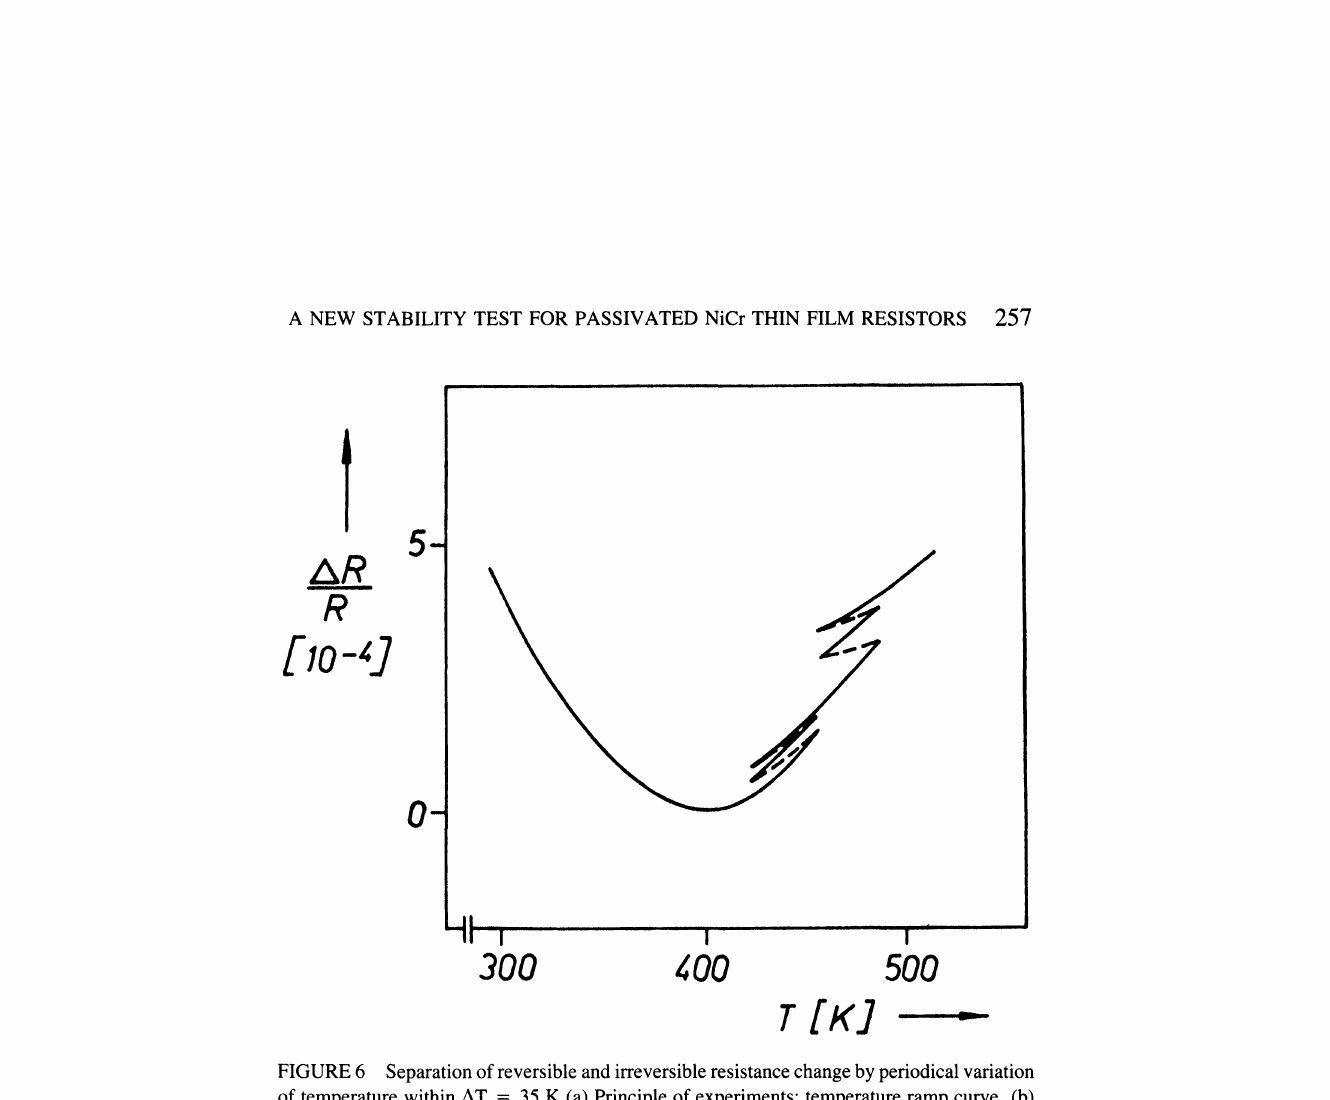
FIGURE 6 Separation of reversible and irreversible resistance change by periodical variation of temperature within AT 35 K (a) Principle of experiments: temperature ramp curve. (b) Slope of the periodically passed curve branch acc. to Fig. 6(a) at two temperatures: deter- mination of reversible part (differential TCR) and irreversible one (o0. (c) Irreversible re- sistance change per degree o versus temperature (same samples as in Fig.